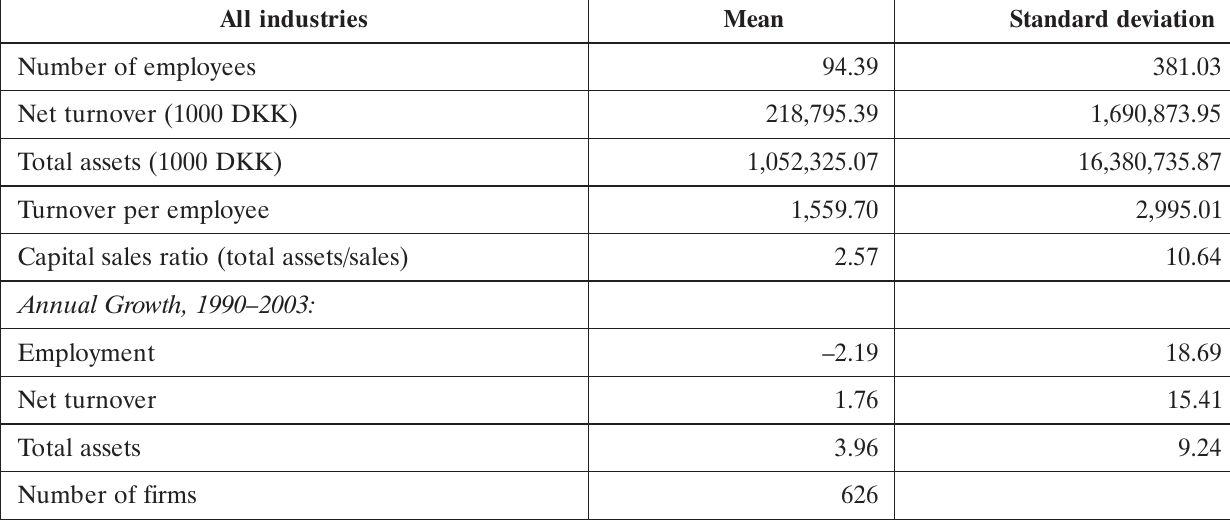
Table 1. Summary statistics for all variables included in the data set, 1990